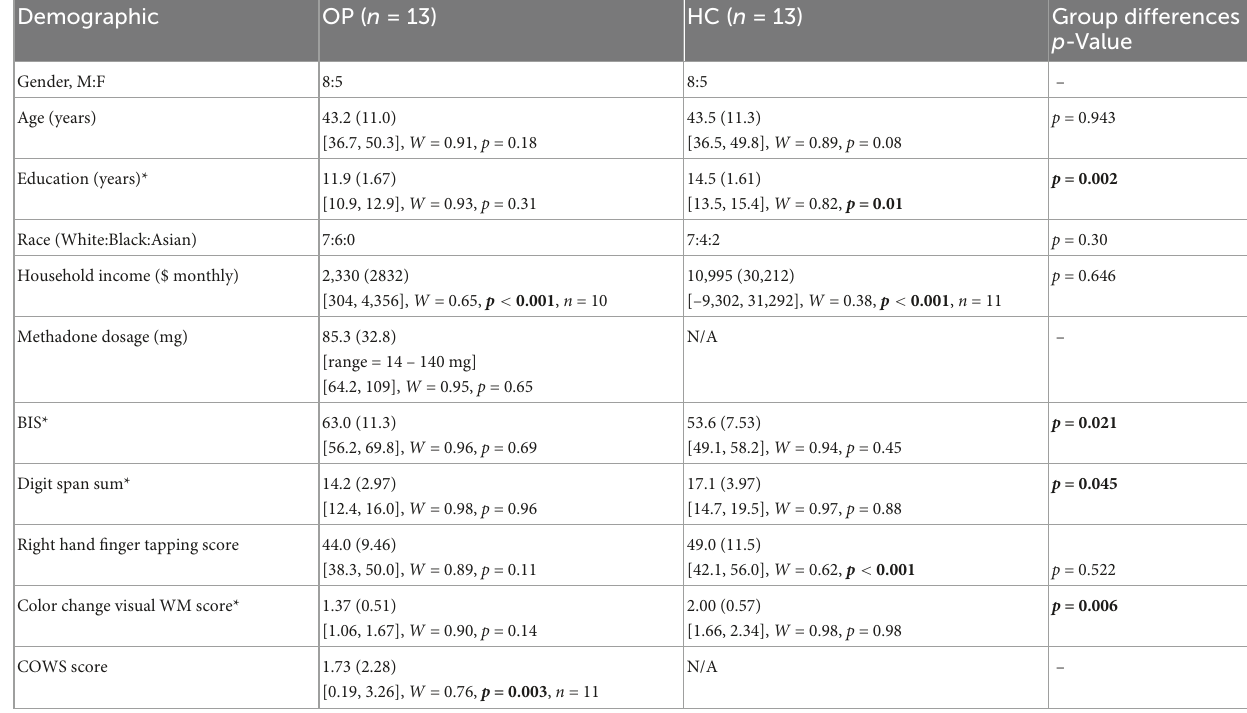
TABLE 1 Demographic variables of the study